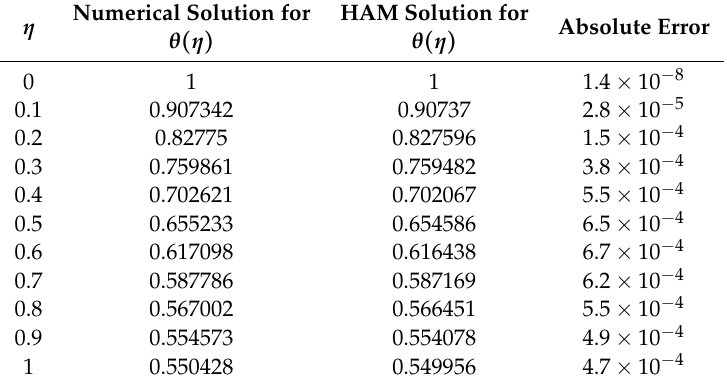
Table 4. HAM, Numerical Solution and their absolute Error are depicted for φ ( η ) , when h = − 0.6,